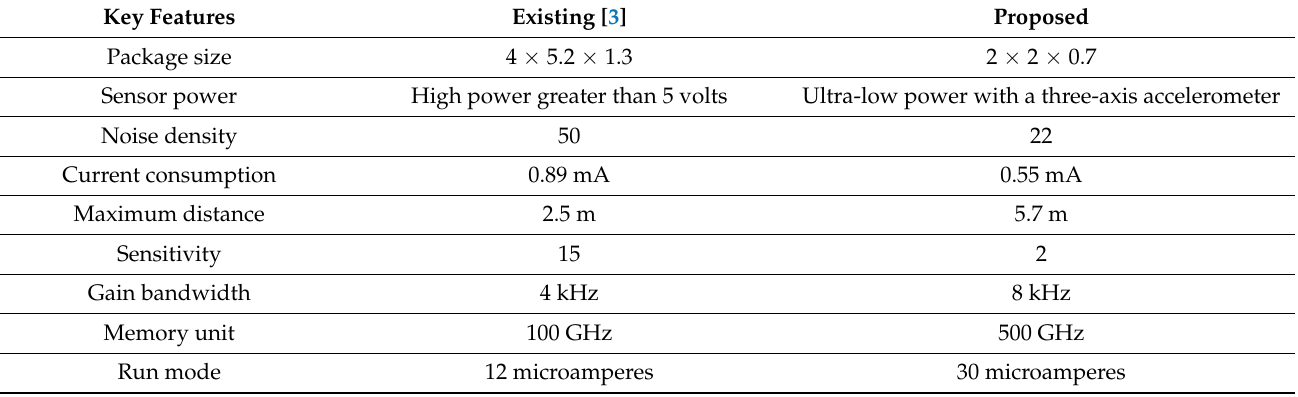
Table 3. Input specifications (existing vs. proposed).